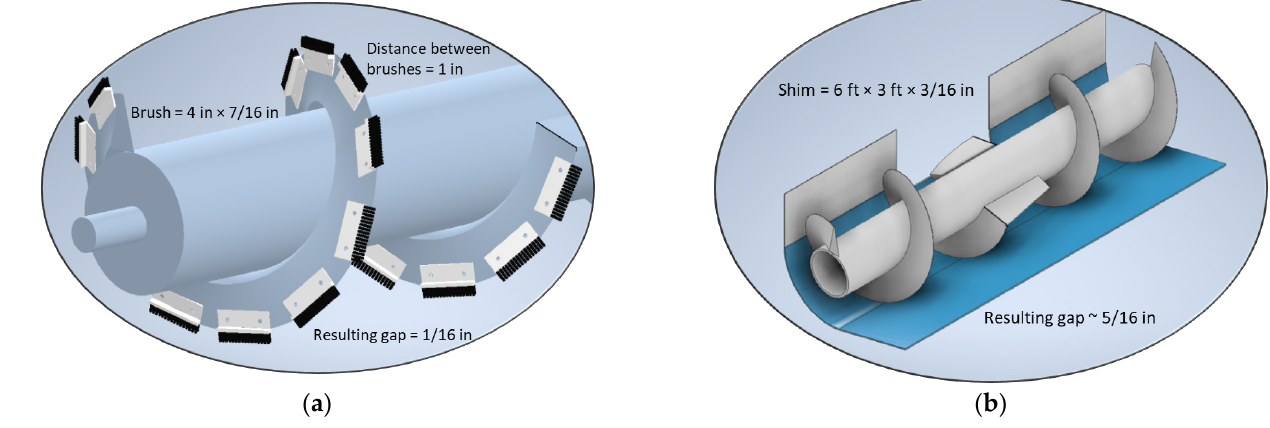
Figure 3. CAD models of auger redesigns: ( a ) brush concept and ( b ) shim concept.